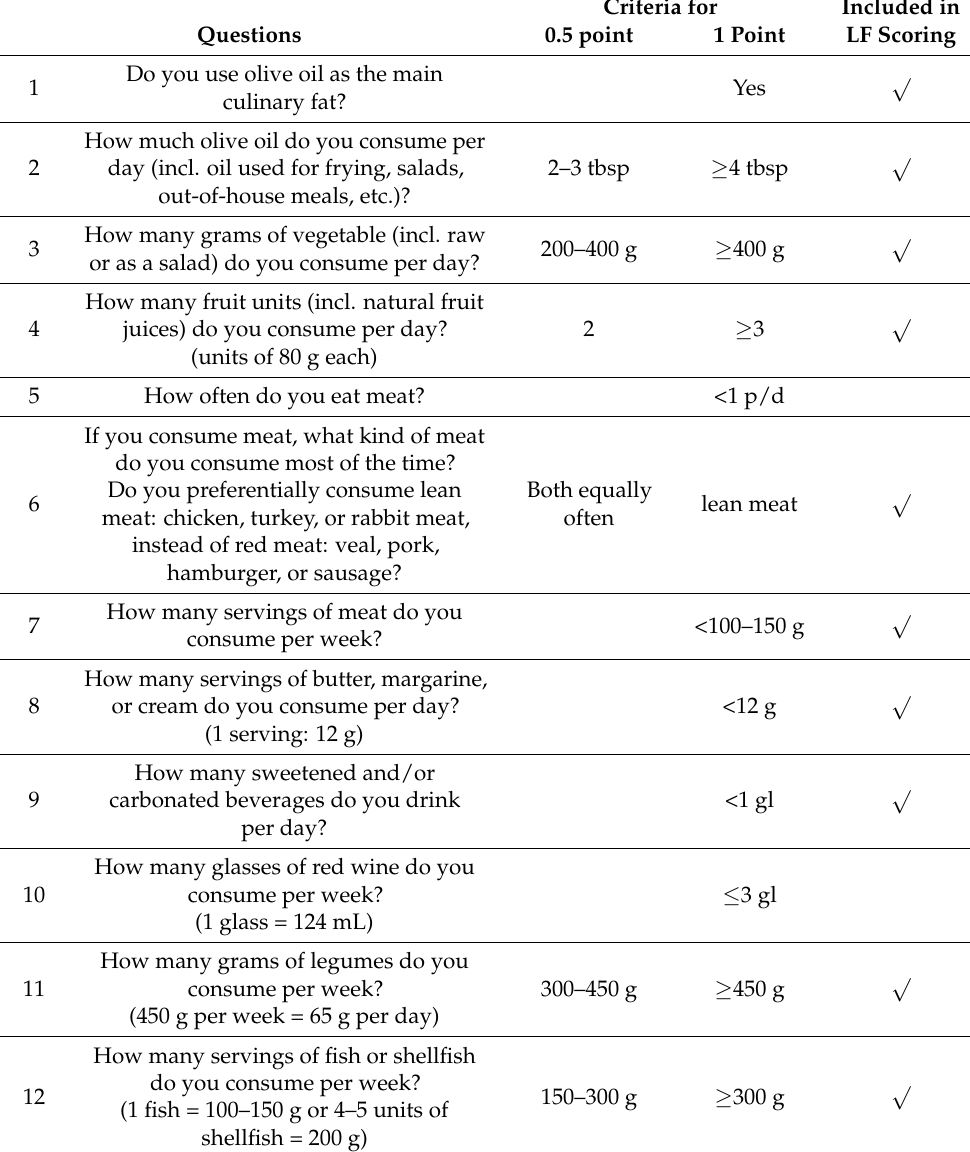
Criteria for Included